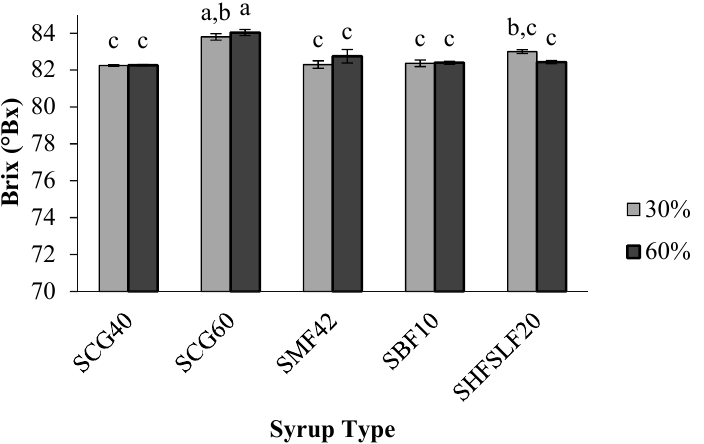
Figure 1. Effect of corn syrup type and concentration on the Brix of the formulated candies. Small letters indicate the significant differences ( p < 0.05) between the samples. Each bar represents a different sample. Errors are represented as standard errors.